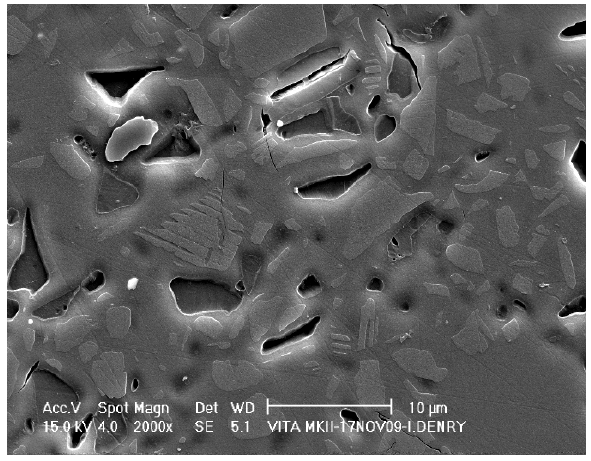
Figure 8. Microstructure of a fully sintered machinable feldspar-based